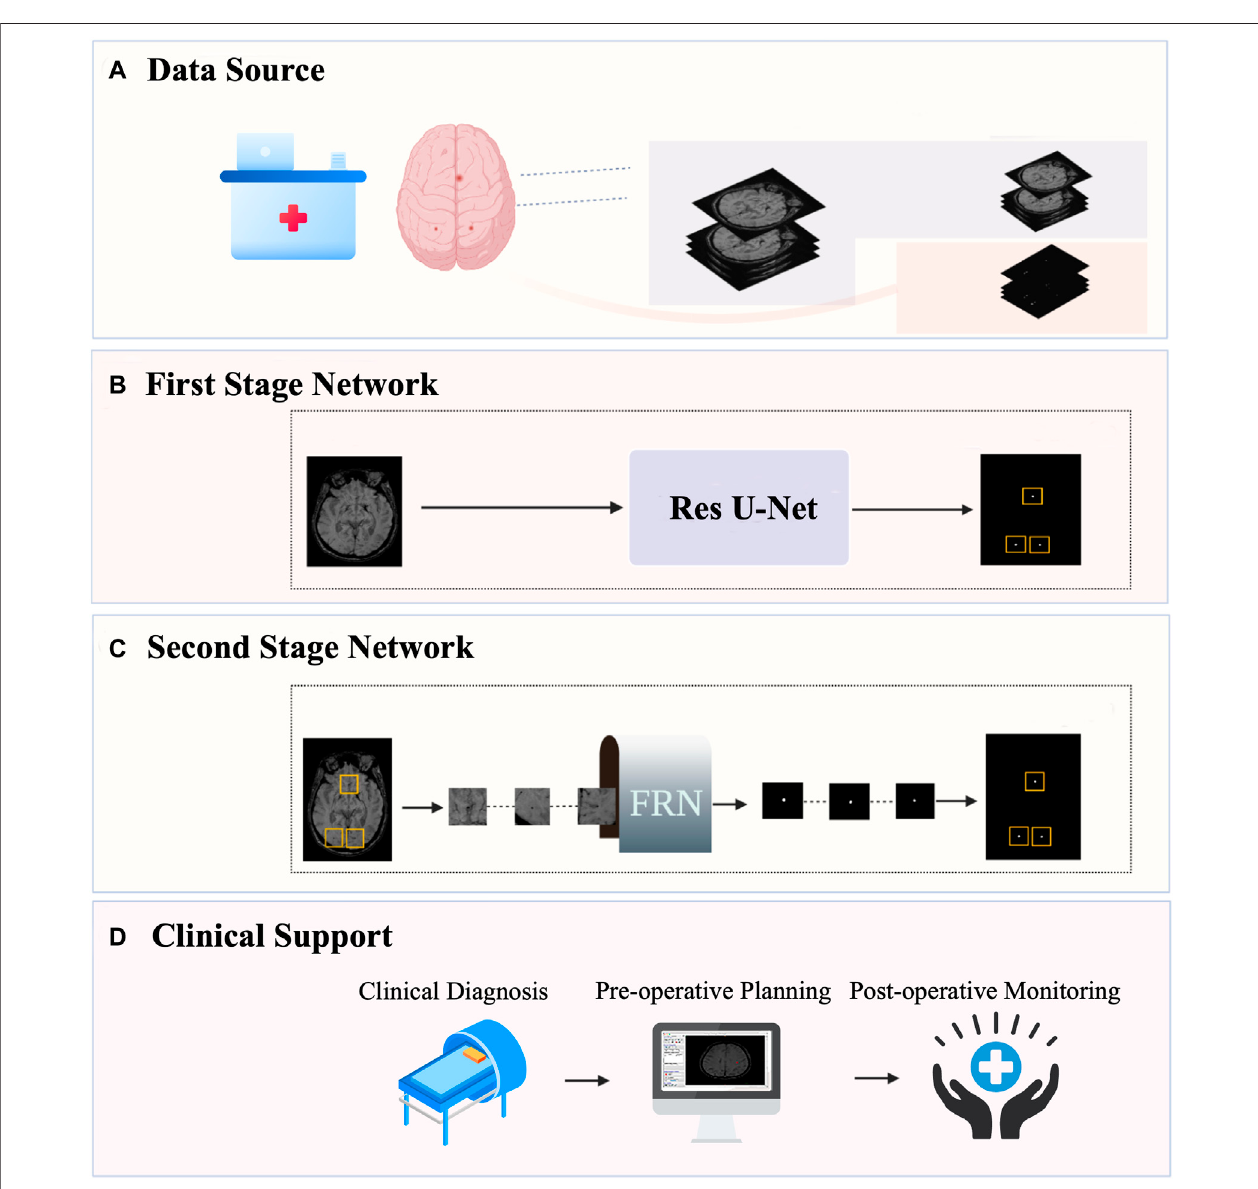
FIGURE 1 | Overall framework of MMOC-Net. (A) Data collection and annotation process; (B) The fi rst-stage coarse segmentation method uses Res U-Net to perform preliminary segmentation and identify the region of interest (ROI); (C) The second-stage fi ne segmentation method: FRN stands for full resolution network. The ROI regions are selected and input into the FRN tocomplete fi ne segmentation. (D) Automatic segmentation can obtain the distribution, quantity and size oflesions and support clinical